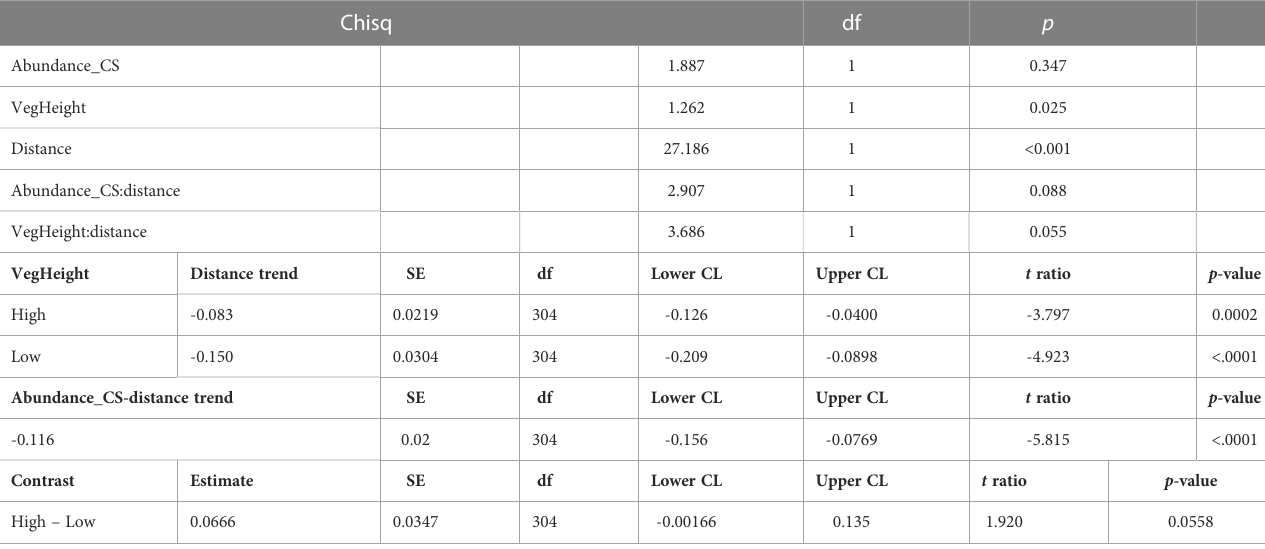
TABLE 4 Upper part: Chisq, degrees of freedom, and p ‐ values for the line model. Chisq